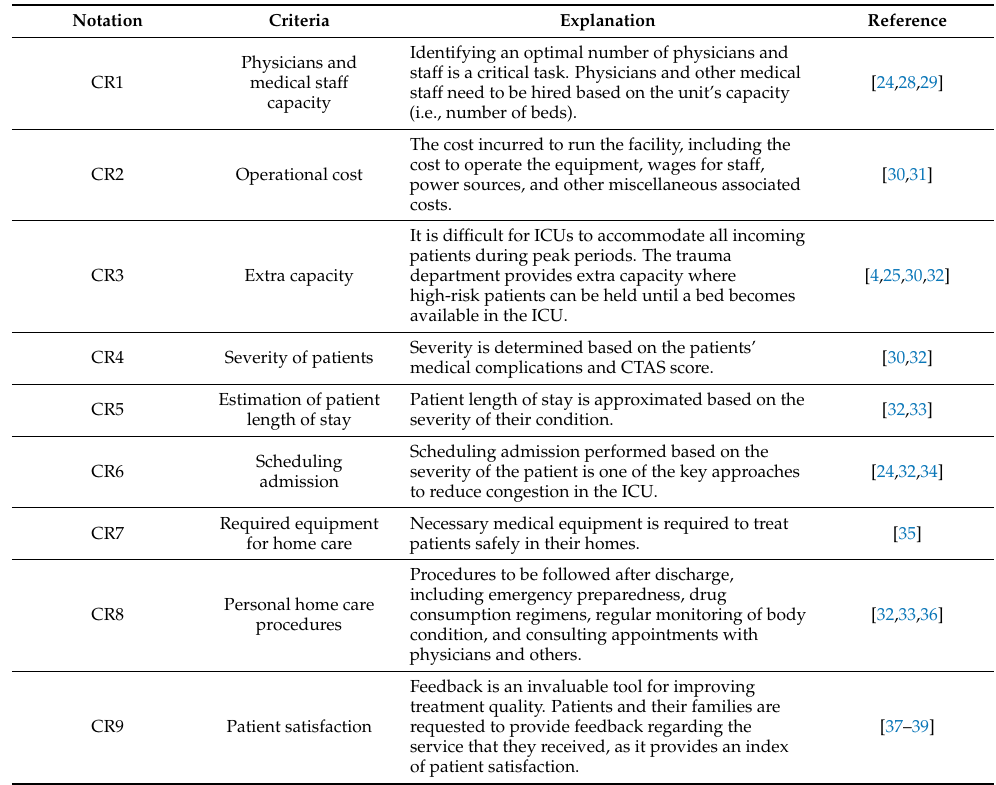
Table 1. Selected criteria for improving quality of patient service in an